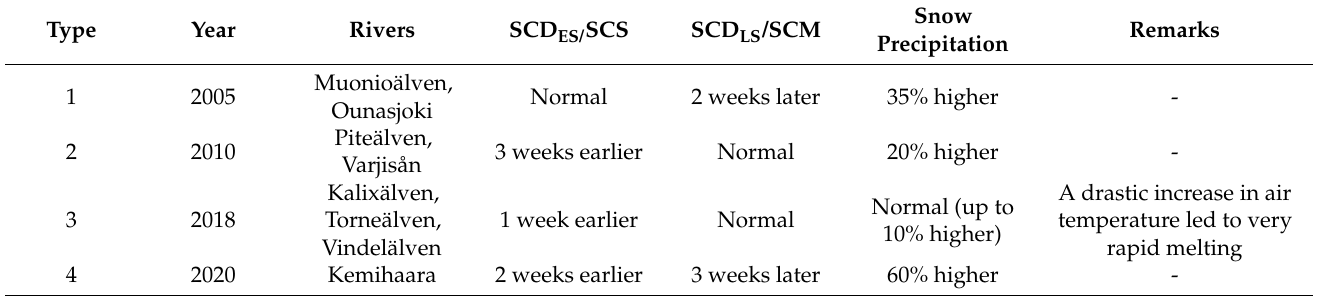
Table 4. Development of measures for different flood types during record